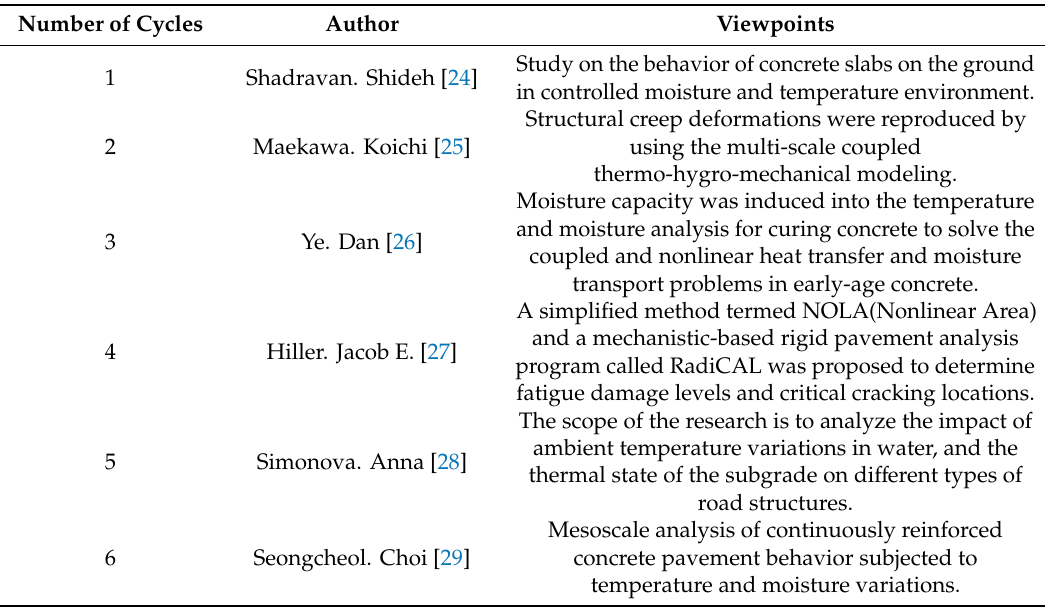
Table 1. Research progress